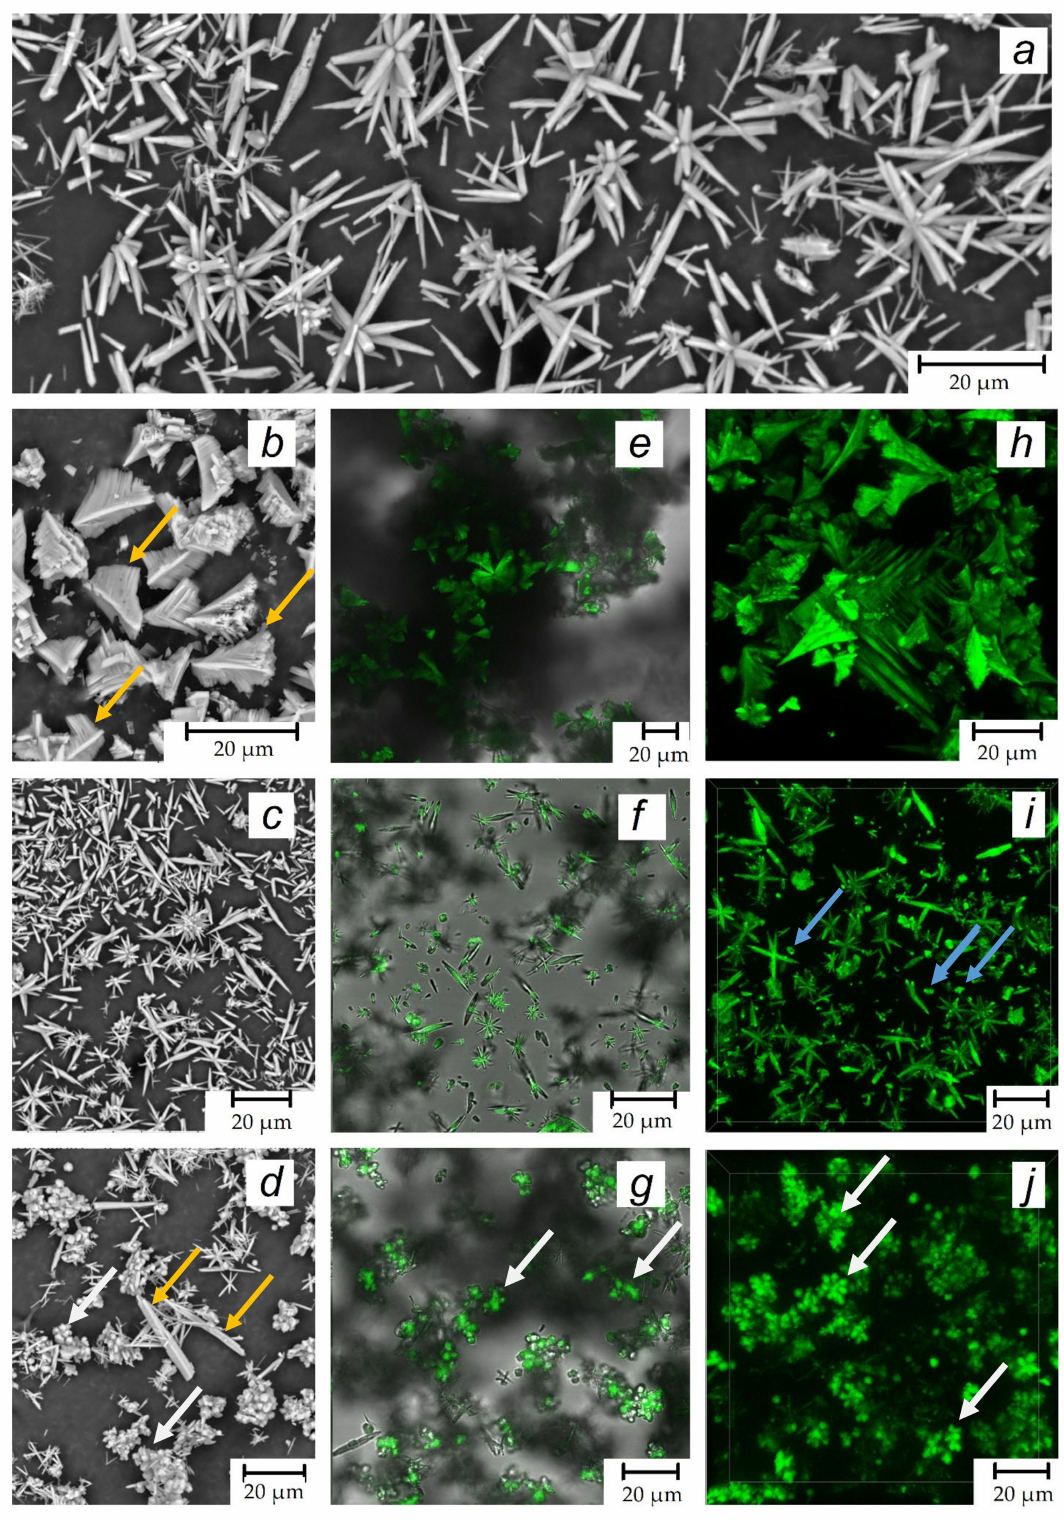
Figure 3. SEM ( a – d ), LSM 2D ( e – g ) and LSM 3D ( h – j ) images of calcium carbonate scale deposited after heating of an aqueous solution of calcium bicarbonate at 70 ◦ C in a blank run ( a ) and in presence of 10 mg · dm − 3 ADMP-F ( b , e , h ), HEDP-F ( c , f , i ) and PAA-F1 ( d , g , j ); ( a – d , h – j ) images correspond to isolated solids, and e,f,g images correspond to aqueous solutions; blue arrows indicate Ca-HEDP-F particles, white arrows indicate vaterite phase, and red arrows correspond to